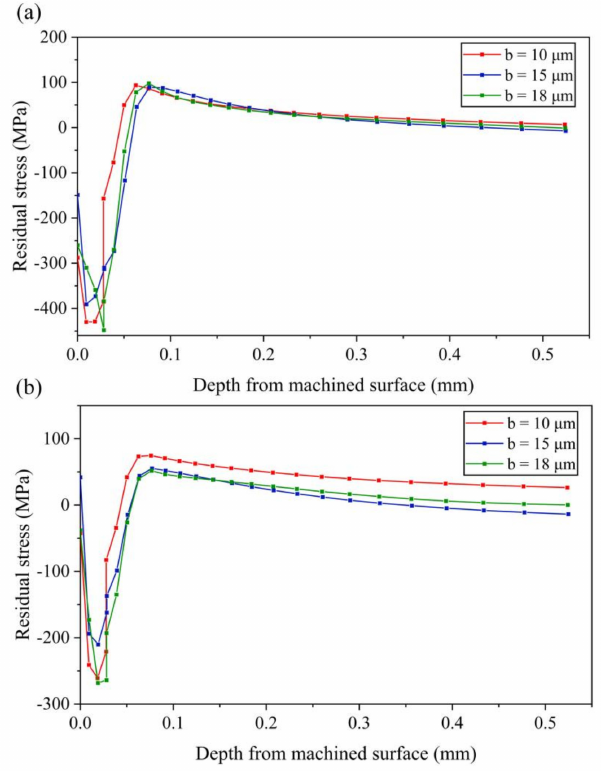
Figure 14. Results of residual stress with various amplitudes b ( a ) stress-xx ( b )